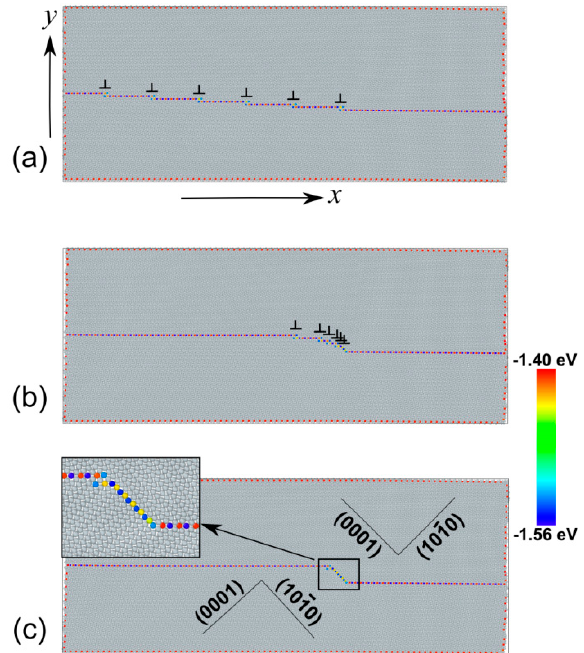
Figure 7. Formation of basal-prismatic facet in {1012} twin by pile-up of disconnections in atomistic simulations: ( a ) an initial configuration of the atomic block with six disconnections (no strain applied); ( b ) the block after (cid:15) xy = 1.5%; ( c ) the block after (cid:15) xy = 3% showing the formation of the basal-prismatic interface. Projection in the [ 1210 ] direction. (Reproduced from [12], with permission from IOP publishing, 2014).